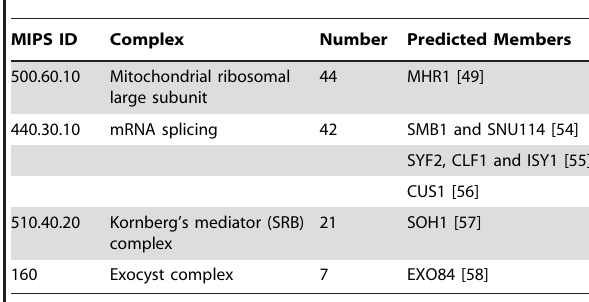
Table 2. Predicted new members of the MIPS